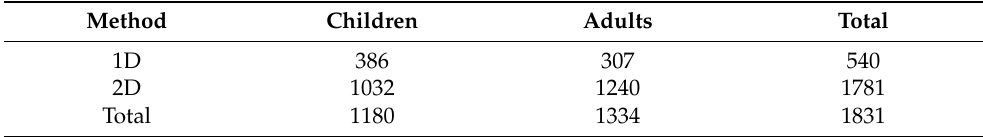
Table 1. Metabolites identified in urine from endogenous.